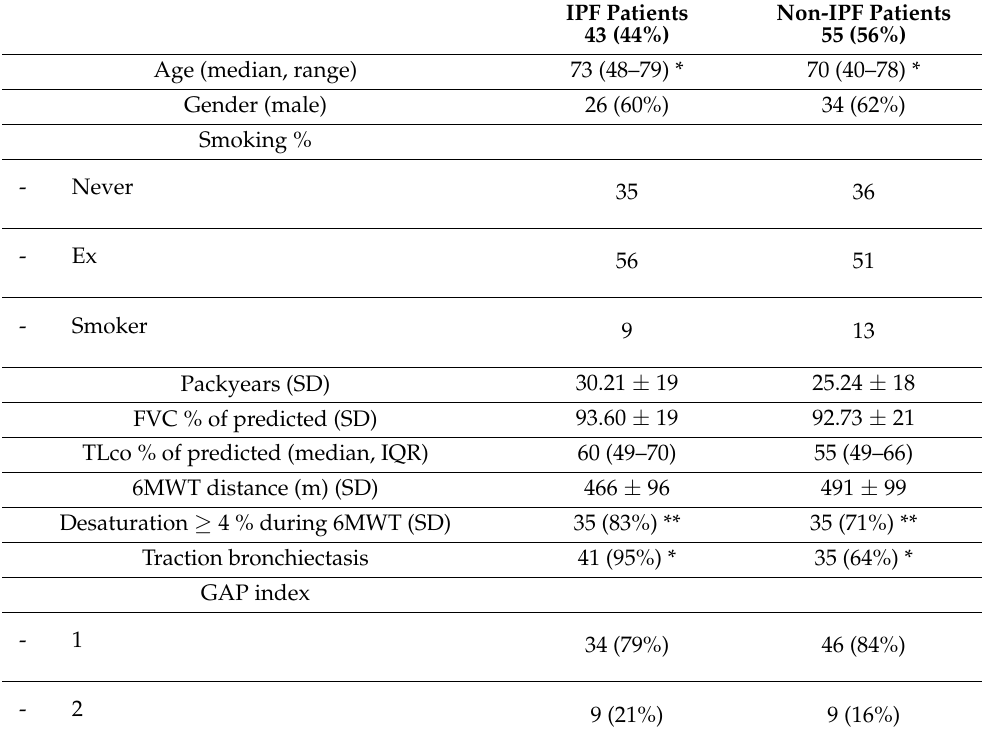
Table 1. Demographic characteristics of patients with IPF and without